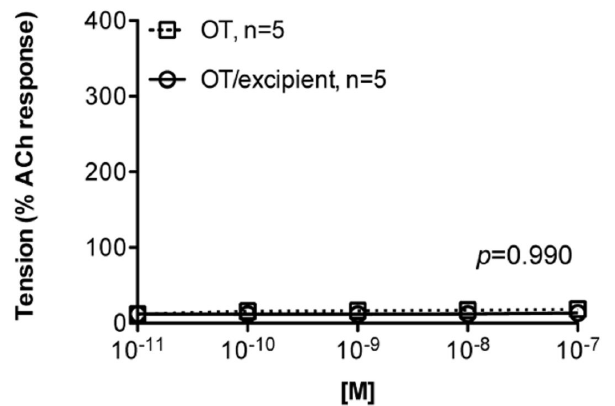
Figure 4. Ex vivo assessment of oxytocin induced tracheal smooth muscle contractions. Effects of applied oxytocin on smooth muscle contractility ex vivo using ovine (n=5) tracheal tissue samples. Contraction was normalized as % of the response to acetylcholine (ACh) in PSS.